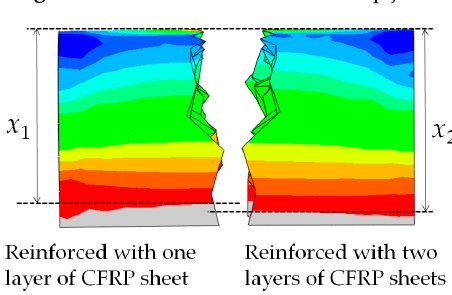
Figure 14. The deformation of the lap joint.